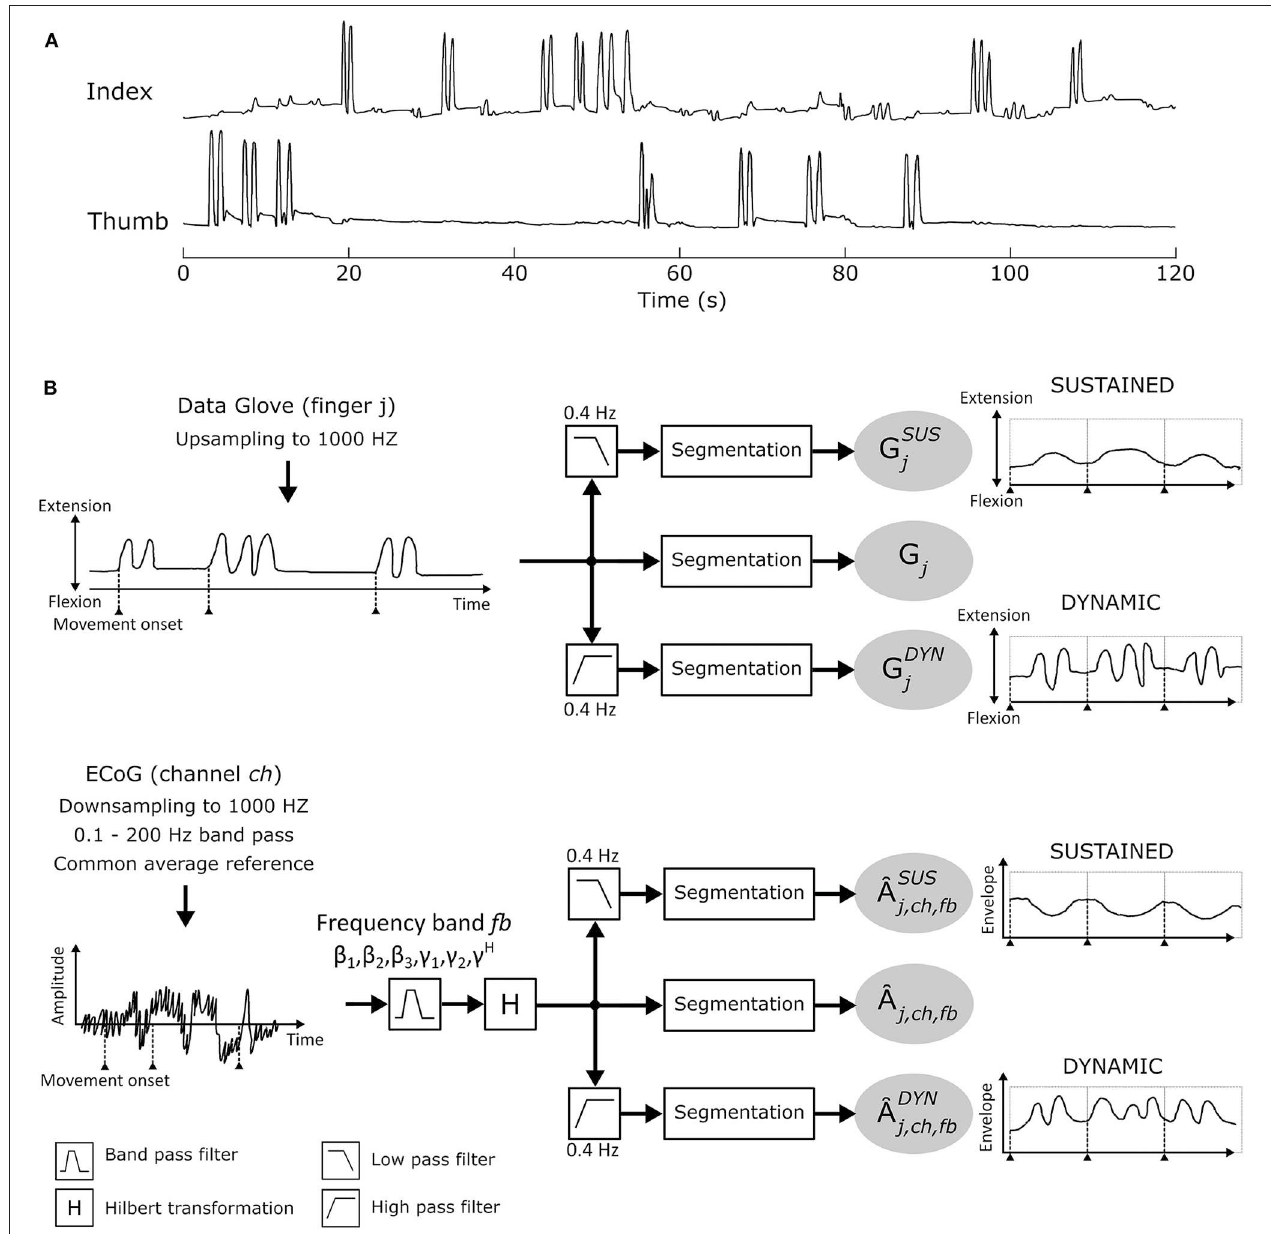
FIGURE 2 | (A) Individual thumb and index finger trajectories recorded with the 5-DOF data-glove for one patient in a time window of 120 s. (B) Signal analysis pipeline.